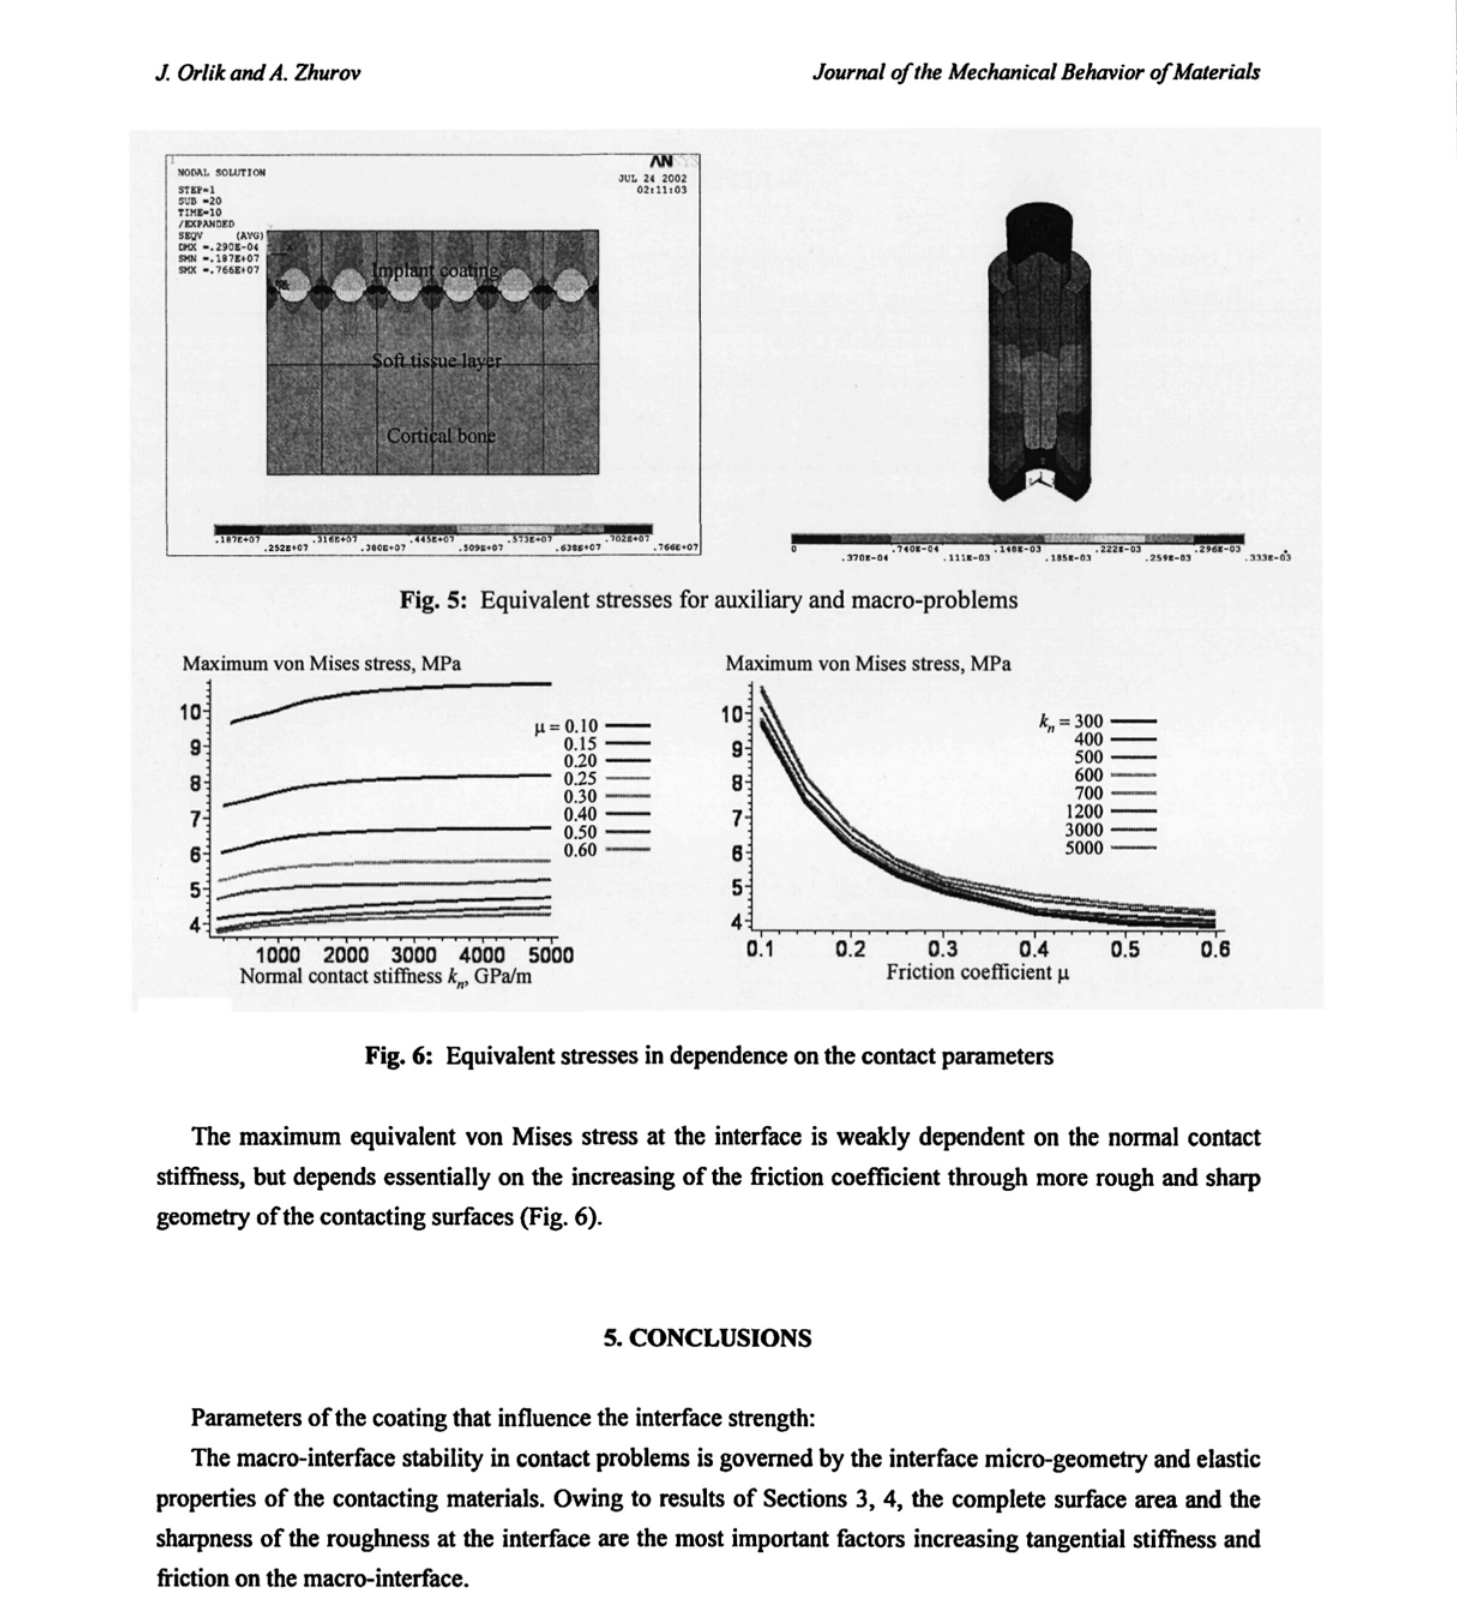
Fig. 5: Equivalent stresses for auxiliary and macro-problems